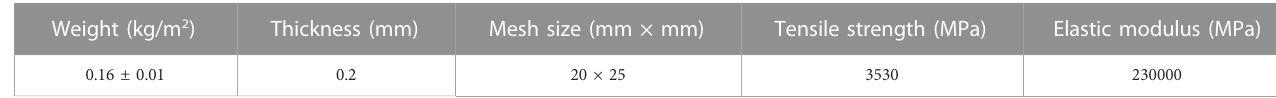
TABLE 1 Properties of PAN textile reinforcement provided by the